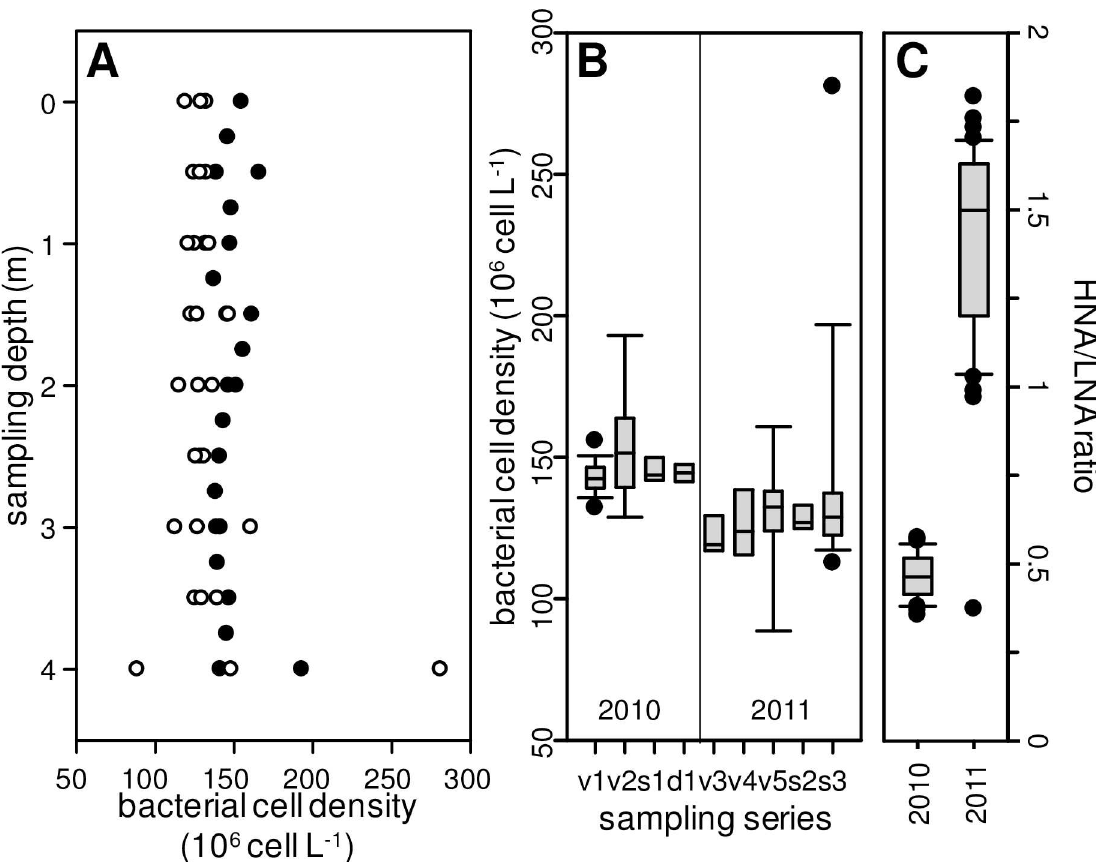
Fig 7. Bacterioplankton cell densities in the Dziani Dzaha. (A) Vertical profilesfrom discrete samples collectedduring2010 (closed symbols) and 2011 (open symbols) surveys. (B) Box-plot indicatingmedian,10th and 90th percentiles (whiskers) and outliers (closedcircles) for bacterioplankton cell densities depending on samplingseries: v = vertical profiles; s = surface spatial sampling;d = deepspatial sampling.(C) Box-plot (same attributes) of high- to low-DNA content bacteriaratio for 2010and 2011